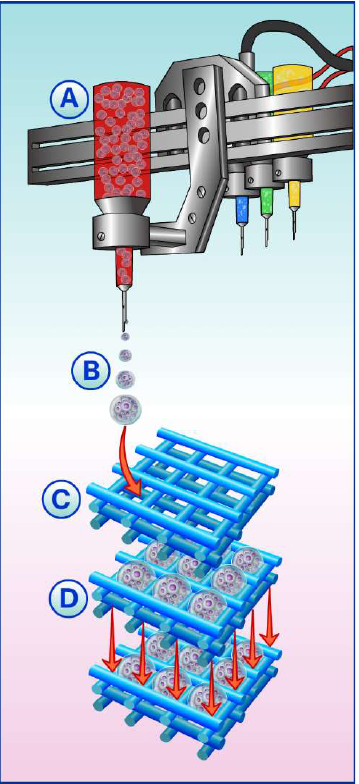
Figure 3. Automated platform for spheroids seeding into 3D printed scaffolds. ( A ) The bioprinter; ( B ) spheroids are dispensed by the bioprinter into the 3D printed scaffolds; ( C ) the 3D printed scaffold; ( D ) the bioprinter dispensing one layer of spheroids for each layer of the 3D printed